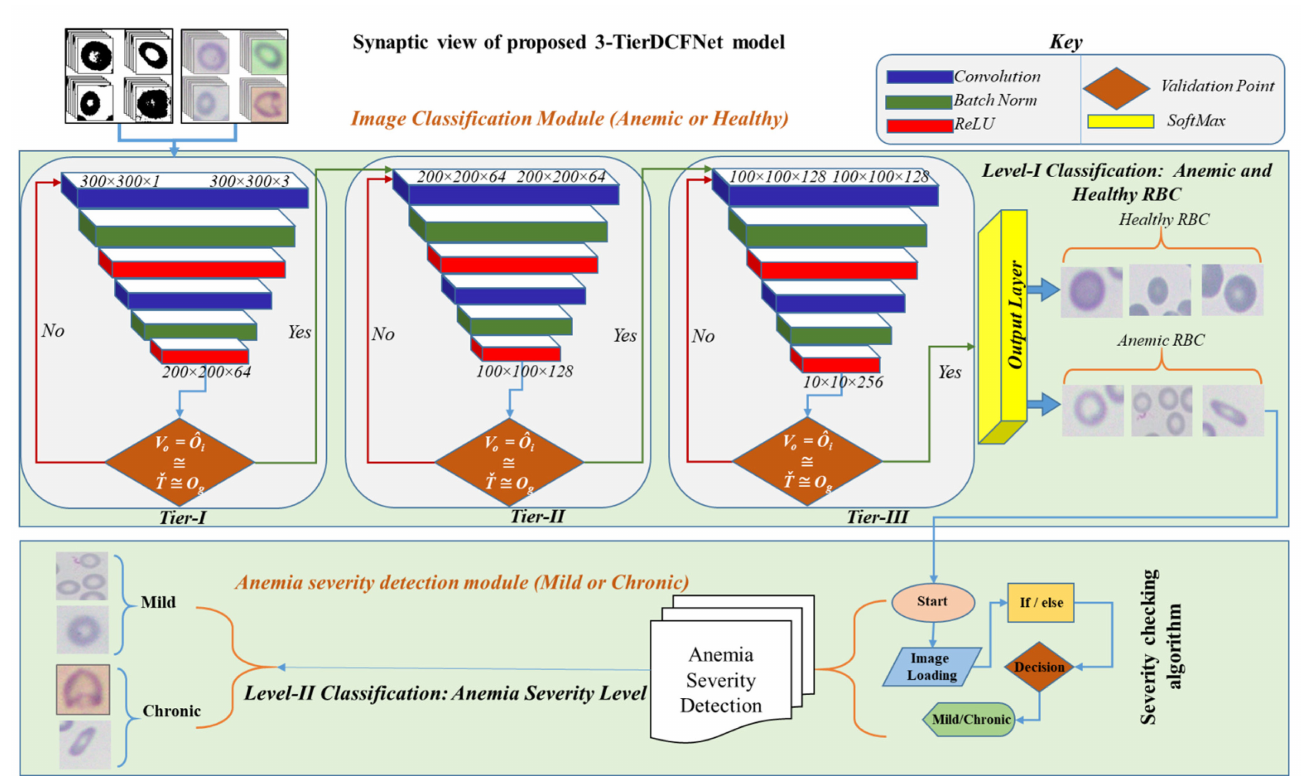
Figure 7. Synaptic view of proposed three-Tier CNN model. The 300 × 300 × 1 represents binary input, while 300 × 300 × 3 represents RGB original image. The label “Yes” means the training accuracy of the n th Tier is equal to the predefined threshold value. The output is then given to the next tier for further processing. The label “No” means the training accuracy of the n th tier is not equal to the predefined threshold value. The output is then given to the same tier for more optimal feature selection. Tier-I includes the DenseNet model that receives inputted images of 300 × 300 × 3 and produces an output of 200 × 200 × 64. Tier-II is equipped with EfficeintNet to preserve semantic information and extract the features up to 100 × 100 × 128; tier-III comprises ShuffleNet, which ensures high accuracy with less computational cost.